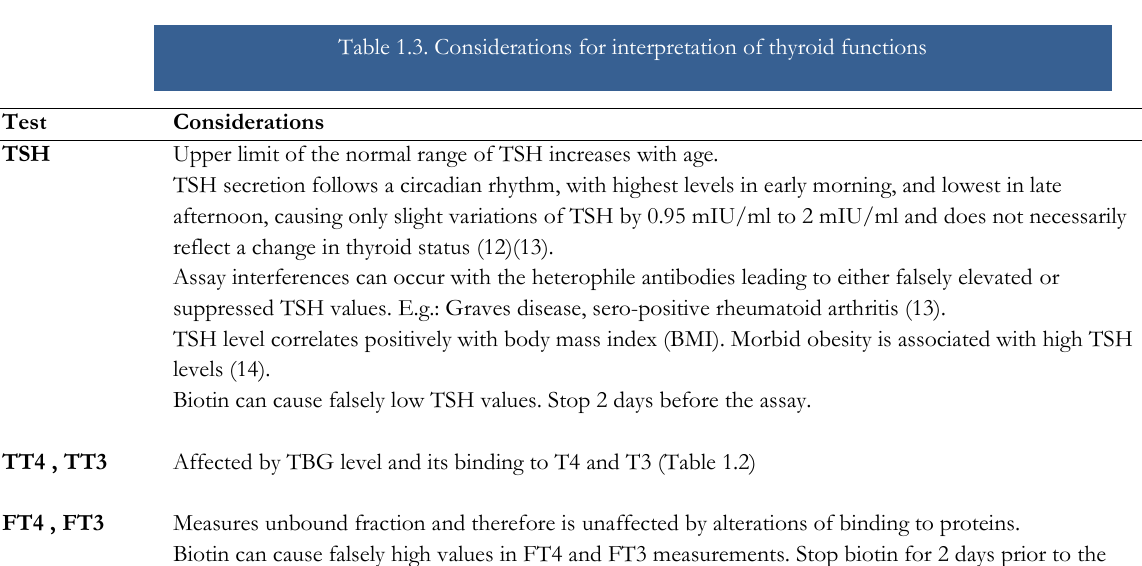
Table 1.3. Considerations for interpretation of thyroid